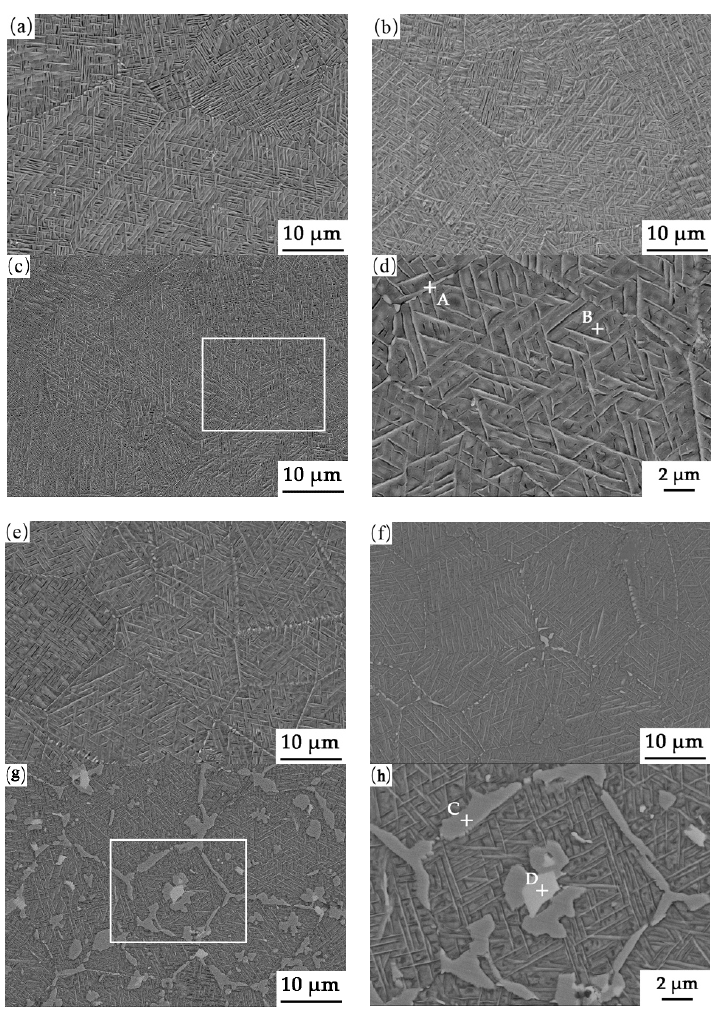
Figure 5. SEM images of the novel low-silver filler metals as-extrude: ( a ) 12AgCuZnSn-1In-0.1Pr, ( b ) 12AgCuZnSn-2In-0.1Pr, ( c ) 12AgCuZnSn-2In-0.15Pr, ( d ) 12AgCuZnSn-2In-0.15Pr (high magnification SEM image of area marked with white square in Figure 5c), ( e ) 12AgCuZnSn-2In-0.3Pr, ( f ) 12AgCuZnSn-2In-0.5Pr, ( g ) 12AgCuZnSn-5In-0.5Pr, ( h ) 12AgCuZnSn-5In-0.5Pr (high magnification SEM image of area marked with white square in Figure